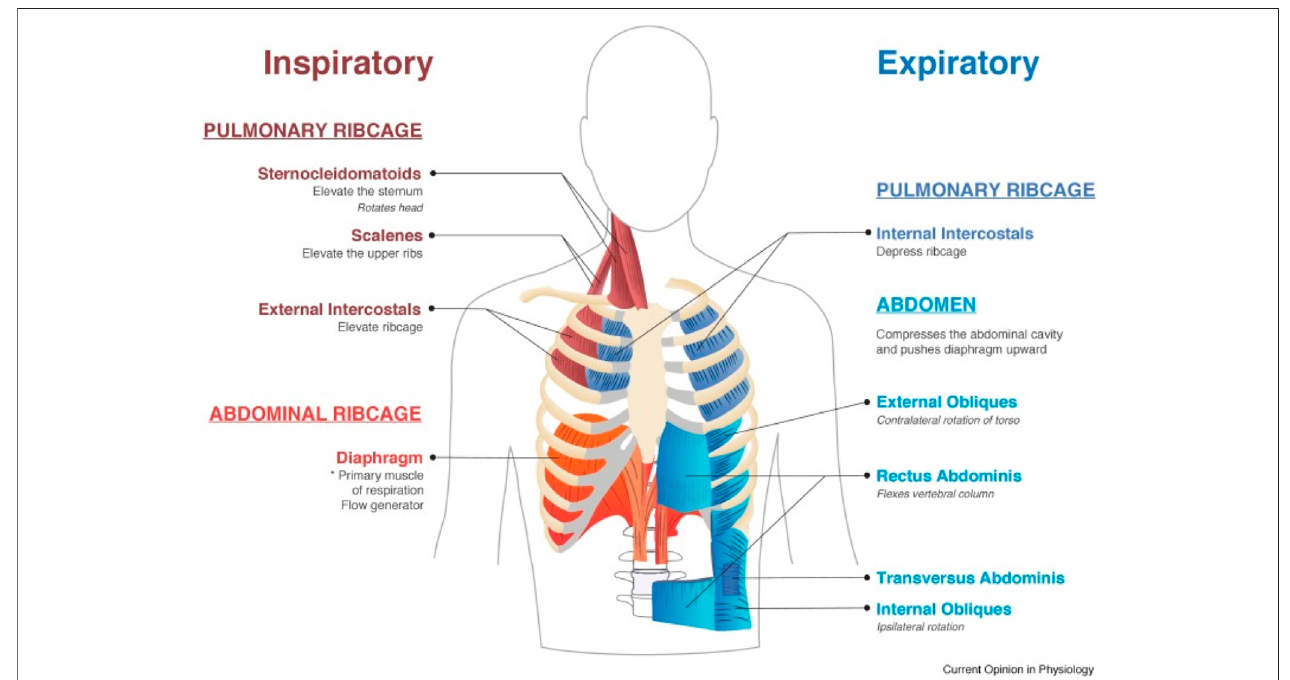
FIGURE 1 | Muscles involved in normal inspiration and expiration. From Welch et al., 2019.